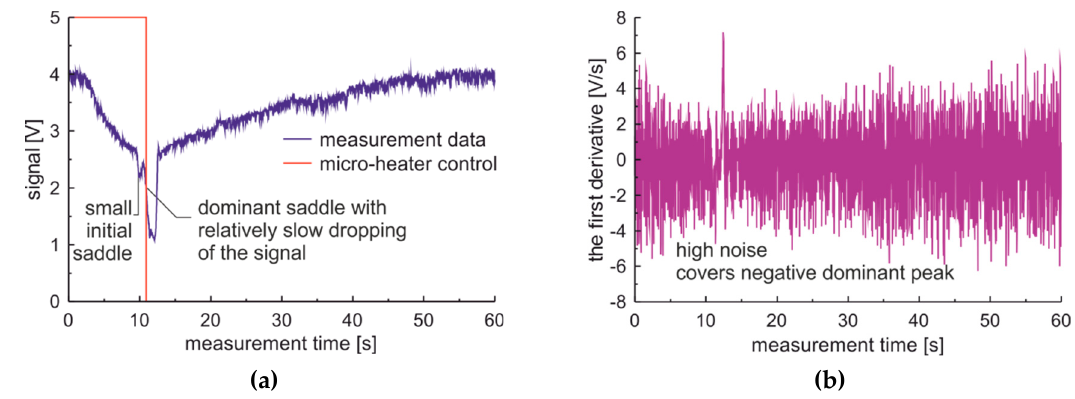
Figure 8. Signals and the first derivative of the measurement cycle obtained for 100% bio-diesel fuel for the sensor located in an area with saturated WiFi transmission: ( a ) Raw signal; ( b ) The first derivative of the raw signal.